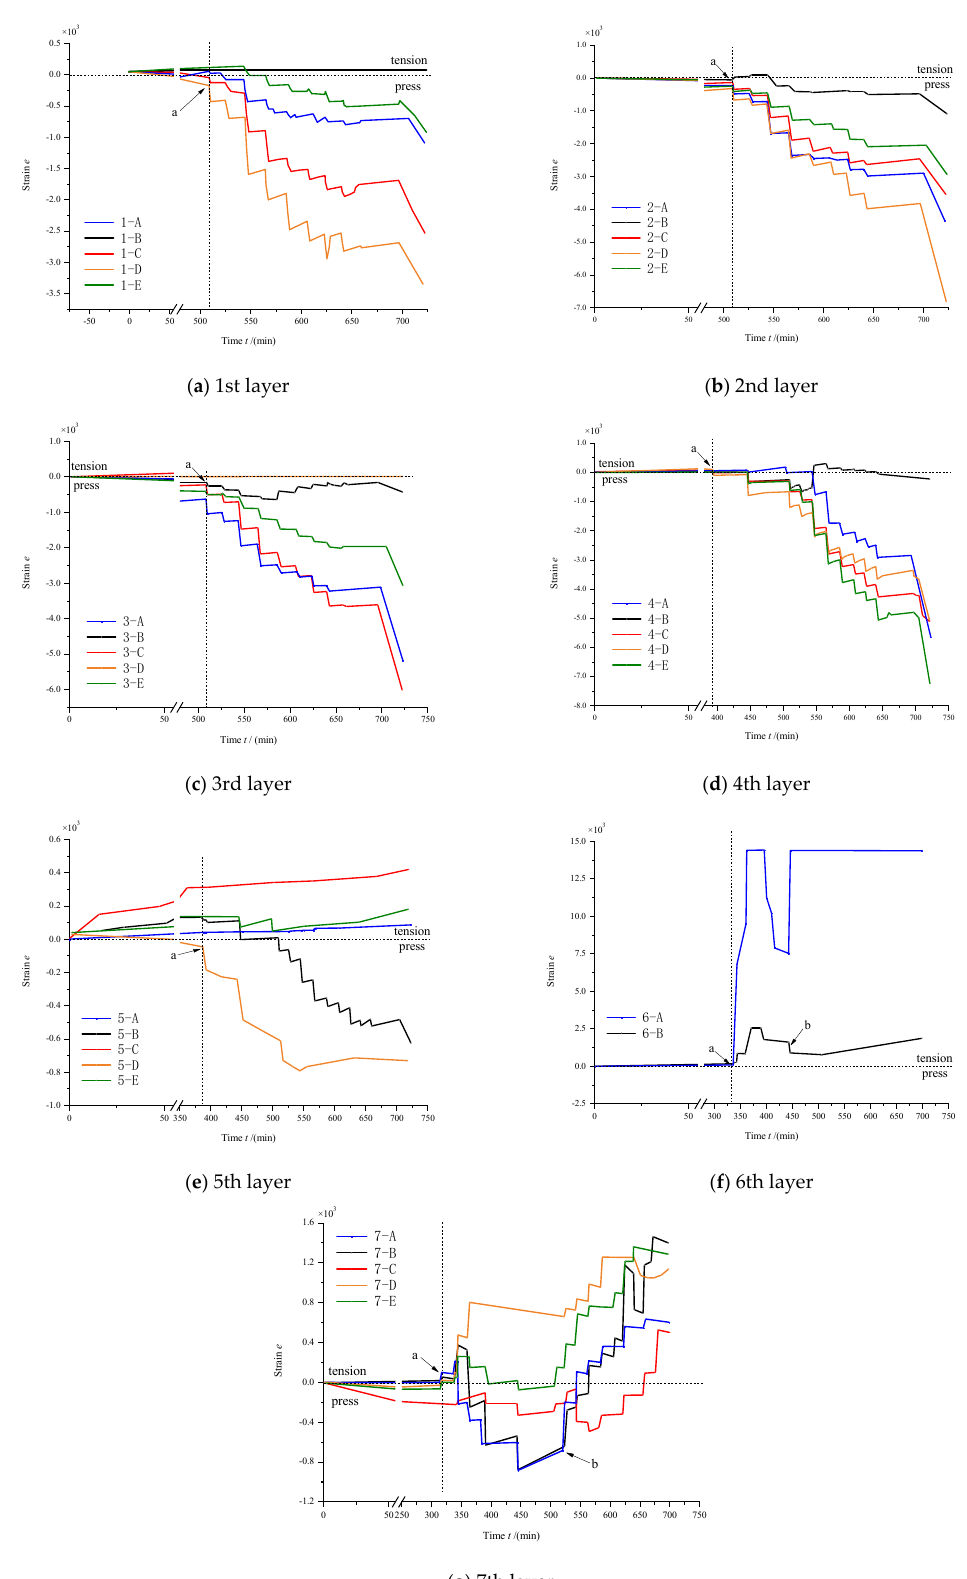
Figure 10. Strain monitored by strain gauges in the loess-bedrock contact zone. The distribution of the location of each layer is shown in Figure 3a. The deformation data regarding the loess-bedrock interface at different times were collected, and the deformation contour of the interface is shown in Figure 11. At 30 min, the trailing edge was thrust and deformed downward, and the deformation in the tunnel and surrounding soil was zero. With the increasing movement of the trailing edge, the soil near the tunnel began to deform. The deformation of tunnel sides was large. At 270 min, a small deformation began to appear at the leading edge of the soil. With the passage of time, the amount of deformation gradually increased and the range of deformation gradually expanded. At 360 min, the upper soil was completely deformed. When it reached the top of the tunnel, the soil was subjected to the tunnel reaction force and tended to move upward, so the direction of movement gradually developed to the back edge of the slope. At 600 min, the reaction force of the tunnel on the soil was higher than that of the thrust, and the soil began to exhibit an extrusion deformation at the trailing edge. The location of the tunnel became the boundary of the displacement deformation. The upper soil of the tunnel moved upward, mainly manifested as soil uplift. In the lower part of the tunnel, the soil continued to move downward, showing a sliding failure mode. ( a ) 30 min ( b ) 270 min ( c ) 360 min